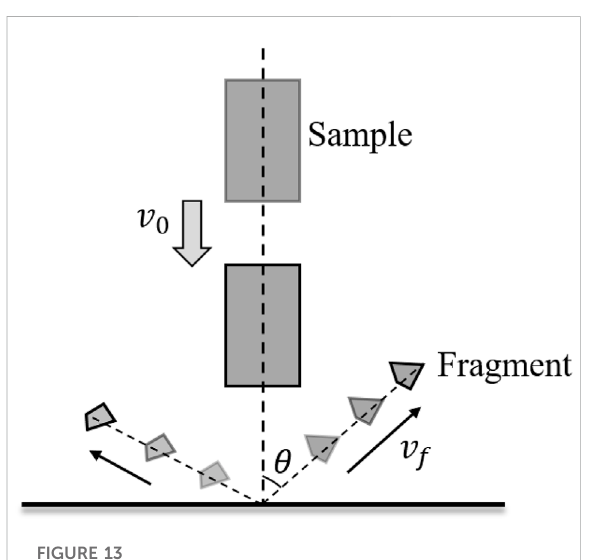
FIGURE 13 Schematic diagram of fragment fl ying velocity and